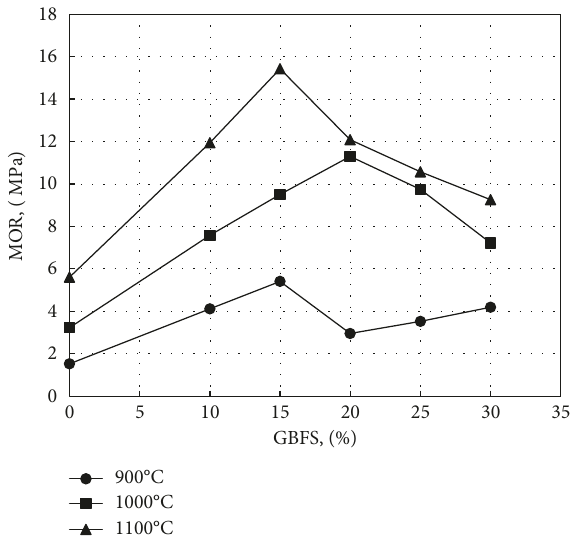
Figure 16: Effect of GBFS Addition on MOR. Table 3: Comparison between the properties of the suggested sample and standard